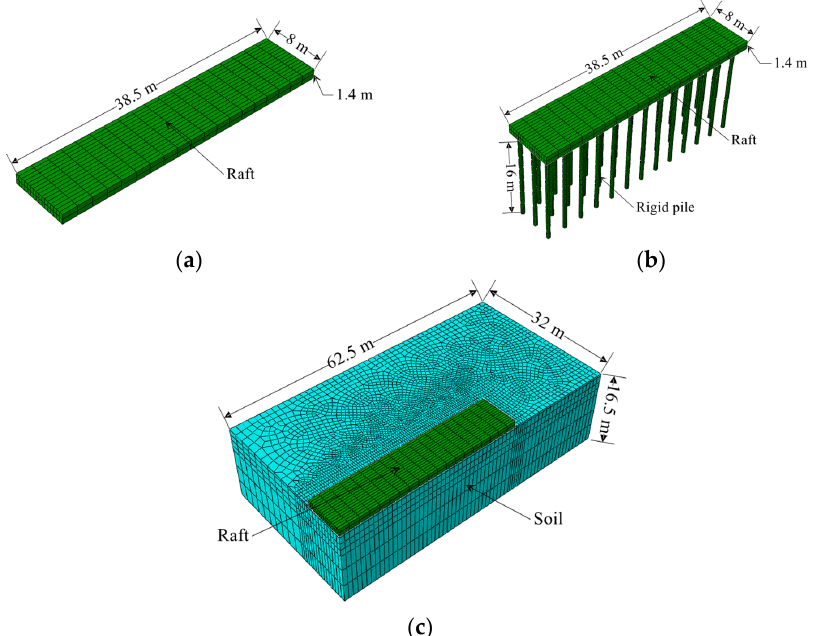
Figure 14. Finite element model of rigid pile composite foundation of Building 15: ( a ) raft; ( b ) raft and pile; and ( c ) FEM model.